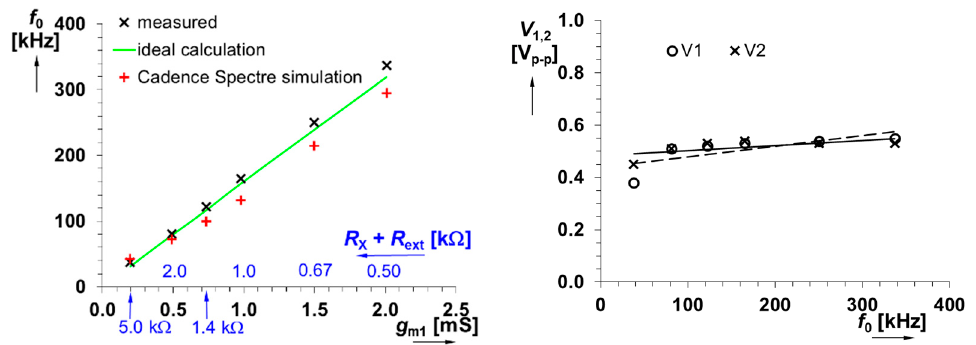
Figure 16. Measured dependences with linear tuning of the frequency of oscillation (FO) of the oscillator: (left) f 0 versus simultaneous control of g m1 ( V set_gm1 ) and R x ( I set_Rx ); (right) amplitude levels of V 1 and V 2 versus f 0 .